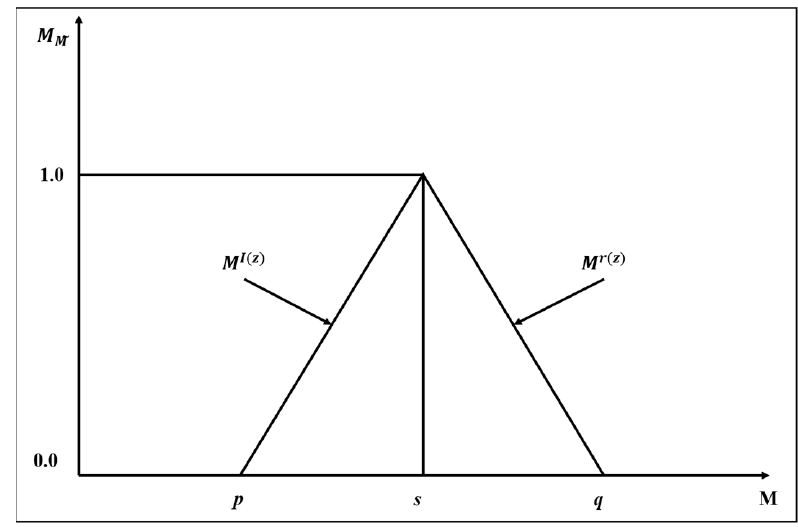
Figure 4. Triangular fuzzy member (TFM) M ͂.